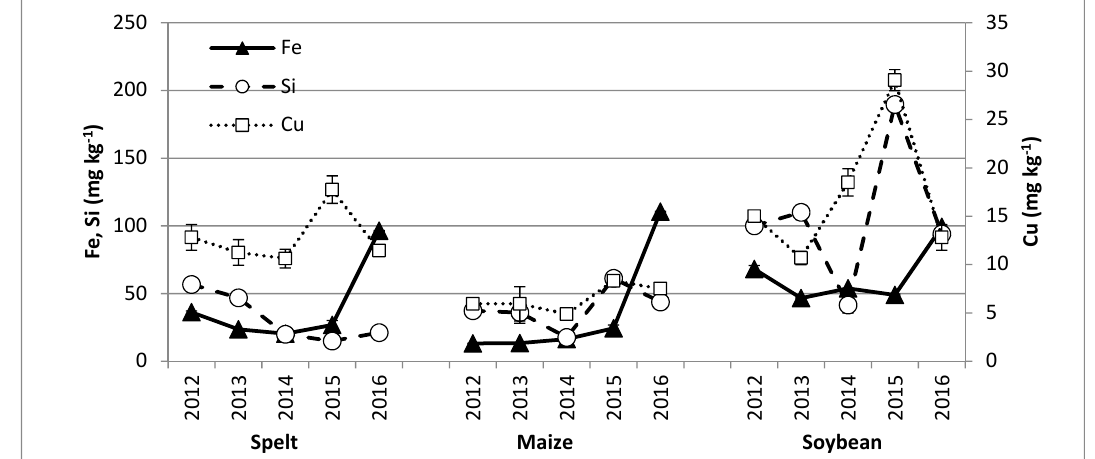
Figure 8. The variation of Ca and Mg concentration in grain of organically producedspelt, maize, and soybean (bars represent SD values).